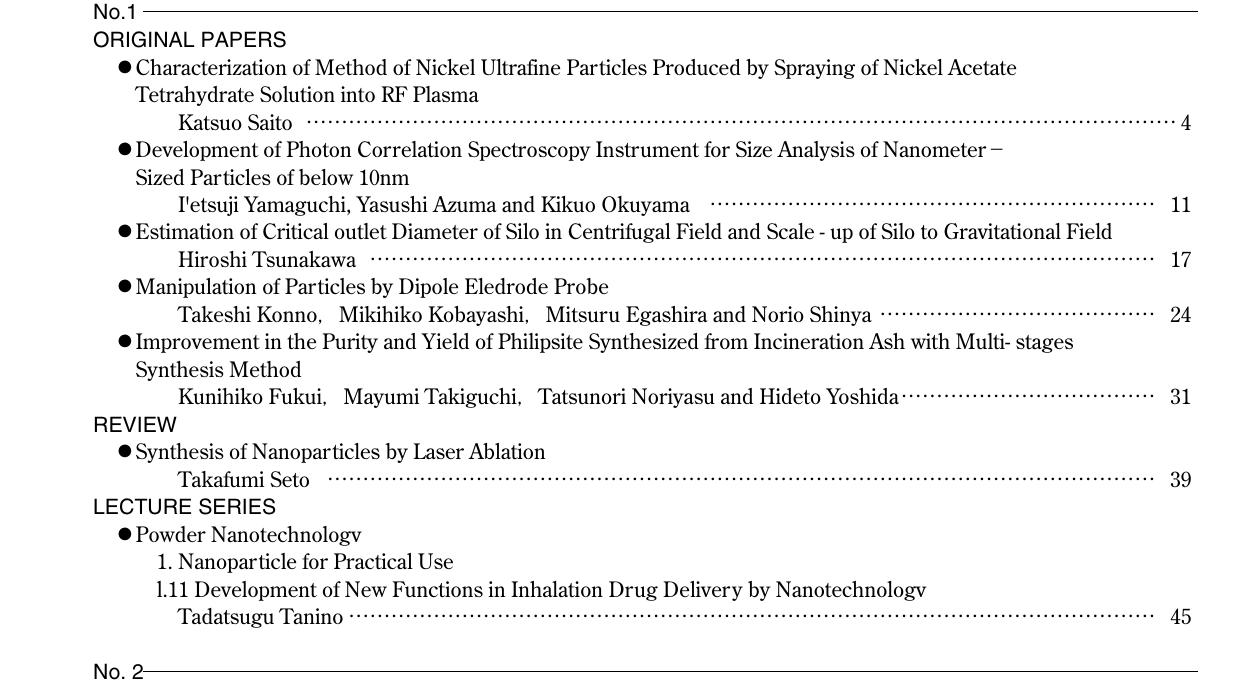
l.11 Development of New Functions in Inhalation Drug Delivery by Nanotechnologv